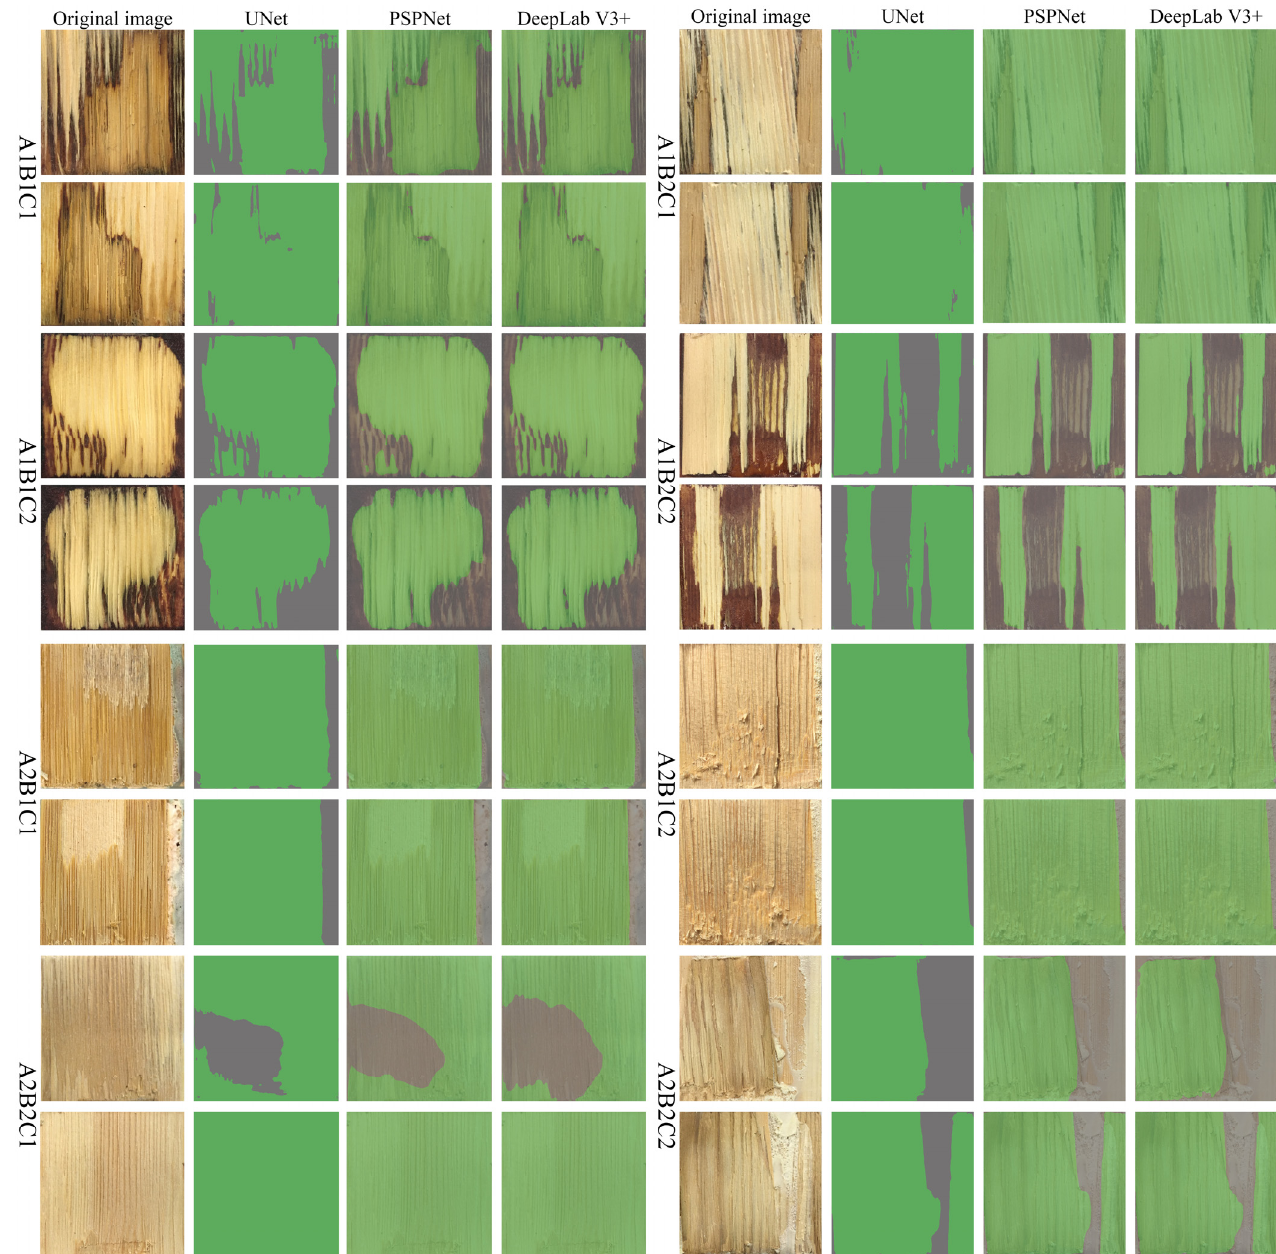
Figure 10. Prediction results of three semantic segmentation models under different conditions. Second, the greater impact on the measurement is the adhesive color change. When the adhesive is PF, the WFP can be measured, and the difference with the actual wood failure areas is small (Figure 12a). However, when the adhesive is MDI, the prediction effect is relatively poor (Figure 12b) [36]. The main reason is that the inherent color of PF is darker compared with MDI, the inherent color difference with the wood failure areas is more obvious, and the semantic information is very clear [37]. Therefore, the PF adhesive region is more easily